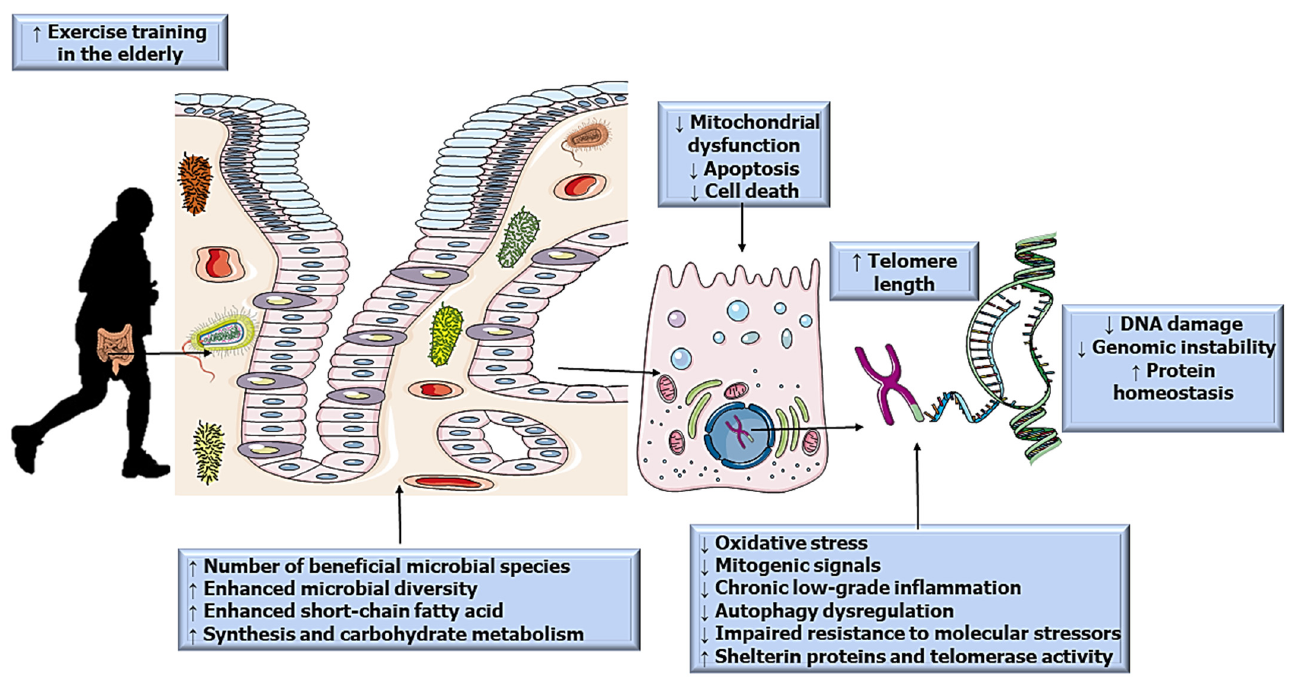
Figure 1. Schematic representation of the hypothetic mechanisms of how exercise training modulates crosstalk between gut microbiota and telomere length.